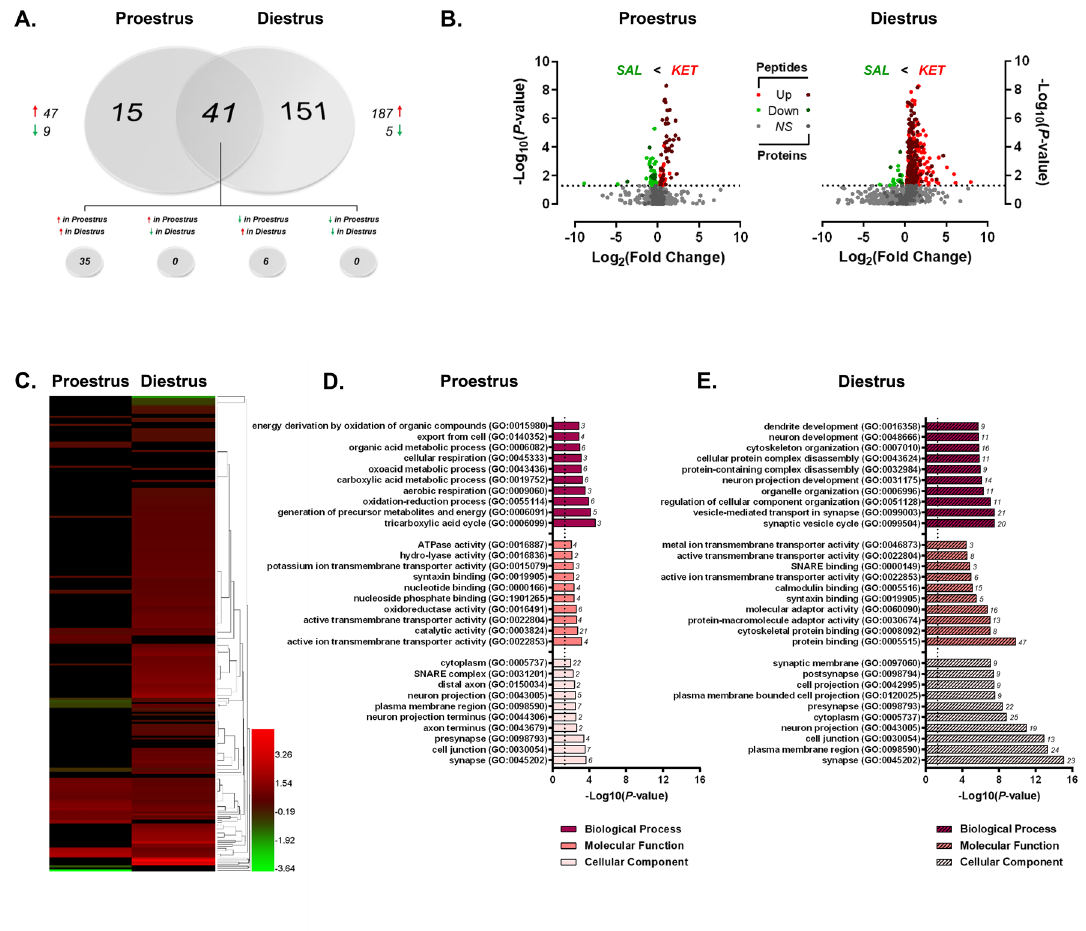
Figure 10. Ketamine-induced changes in the dHPC phosphoproteome of proestrus and diestrus female rats. ( A ) Venn diagram depicting the number of phosphoproteins with significant estrous cycle-dependent differential abundance between ketamine (KET)- and saline (SAL)-treated proestrus or diestrus female rats. Red arrows indicate greater levels observed in KET- vs. SAL-treated rats. ( B ) Volcano plots showing significant KET-induced alterations in dHPC phosphoprotein abundance in proestrus (left) and diestrus (right) female rats. Log 2 (Fold Change) values > 0 (red) indicate higher—and those < 0 (green) lower—abundance in KET-treated rats compared to SAL groups. Points above the horizontal dashed line represent proteins with p < 0.05 (FDR threshold set at 1%). ( C ) Heat map illustrating fold change of phosphoproteins significantly affected by KET in either proestrus or diestrus female rats. Top 10 most significant ( p < 0.05) gene ontology (GO) enrichment terms per category of phosphoproteins with significant KET-induced differential abundance in proestrus ( D ) and diestrus ( E ) female rats. Heat map ( C ) was produced in GENE-E (Broad Institute; https:// softw are. broad insti tute. org/